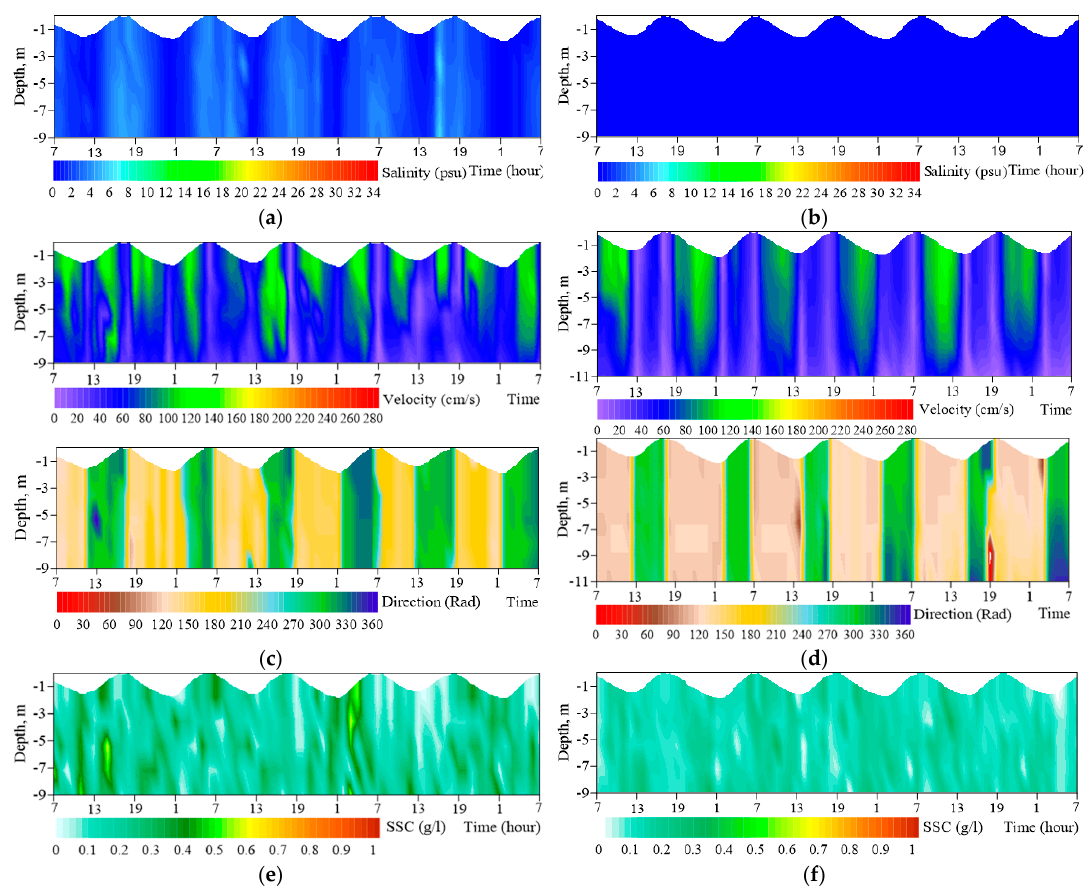
Figure 3. Time series plot of the distribution of salinity, currents (velocity, direction), and SSC at Station S0 in the dry season (9–12 April 2009) and flood season (22–25 August 2009): ( a ) salinity in the dry season; ( b ) salinity in the flood season; ( c ) current in the dry season; ( d ) current in the flood season; ( e ) SSC in the dry season; ( f ) SSC in the flood season.